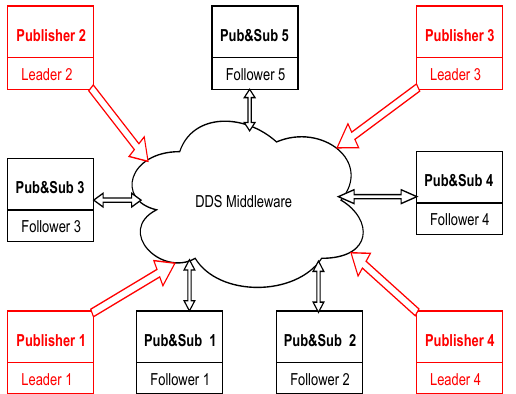
Figure 8. The containment structure based on DDS middleware.